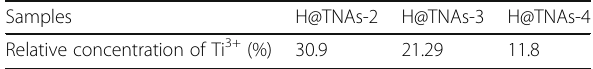
Table 3 Relative concentrations of Ti 3+ of each sample Samples Relative concentration of Ti 3+ (%)